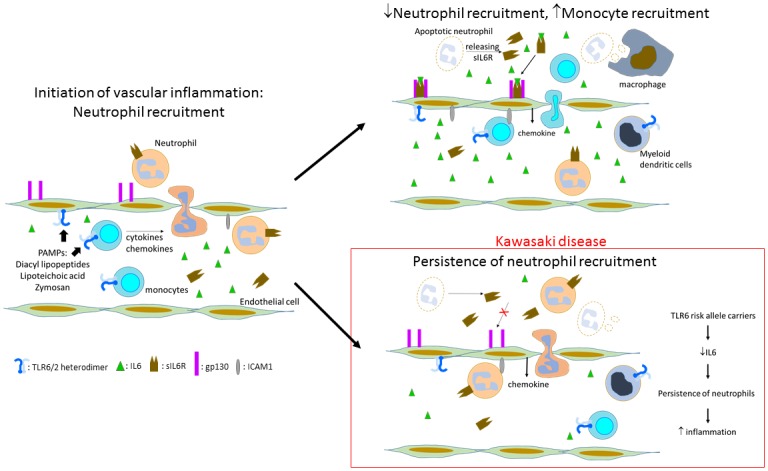
Hypothetical role of decreased IL6 signaling in the persistence of vascular inflammation in acute KD.The TLR6 variants associated with KD are predicted to yield lower levels of NFKB upon stimulation, thus resulting in lower levels of IL6. During vascular inflammation, neutrophil apoptosis is associated with shedding of the soluble IL6R-IL6 complex, which binds to gp130 on endothelial cells. This stimulates a signaling pathway that switches the adhesion molecule and chemokine profile to one that favors attraction of monocytes to the vessel wall with subsequent downregulation of vascular inflammation. In KD, lower levels of IL6 may lead to persistence of neutrophil recruitment to the vessel wall and prolonged inflammation.